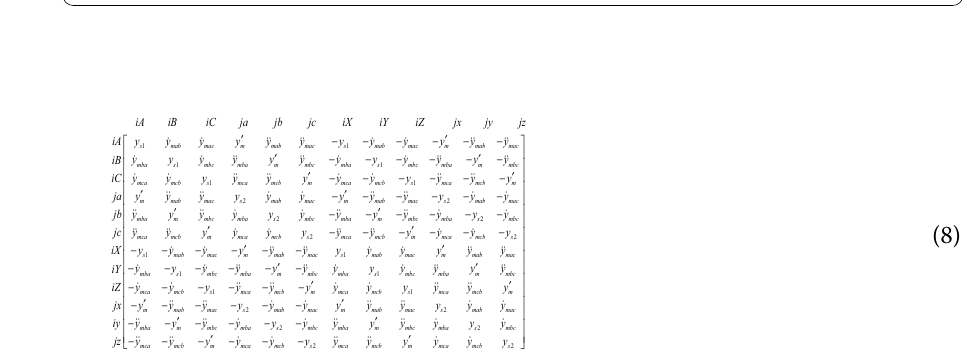
Fig. 6 Three-phase two winding transformer in magnetic circuit asymmetry configuration; Three-phase two winding transformer in magnetic circuit asymmetry configuration shows that there are coupling in windings, as well as the coupling between